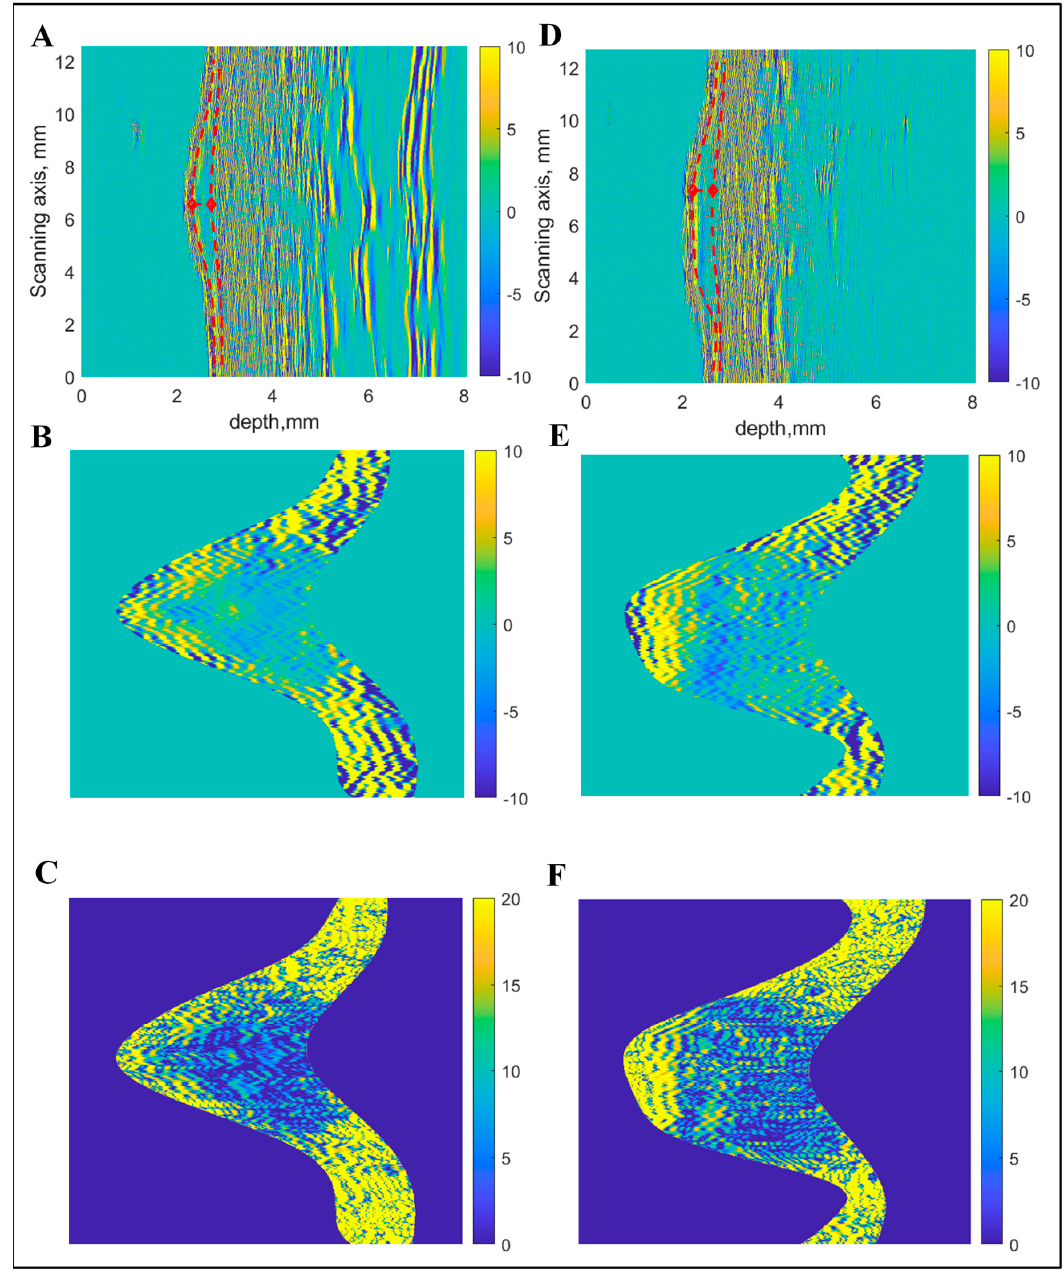
Figure 2. Boundary detection and extraction of region of interest from ultrasonic B-scan: Raw B-scan image ( A ), extracted region of interest with linear scale of amplitudes ( B ) and with logarithmic scale ( C ) in the case of melanocytic naevus (MN). Raw B-scan image ( D ), extracted region of interest with linear scale of amplitudes ( E ) and with logarithmic scale ( F ) in the case of cutaneous melanoma (CM). The range of energy value lies between 0 and 1, that is a numerical descriptor of uniformity. Entropy signifies the statistical measure of uncertainty and randomness and lies between 0 and log 2 (M) (M is the total number of levels in the histogram). The other quantitative parameters (mean, standard deviation, root mean square (RMS), variance, smoothness, skewness and kurtosis) of the intensity value distribution were computed in order to characterize the global distribution of intensity [42]. To characterize the texture feature of the image, the grayscale co-occurrence matrix (GSCM) was